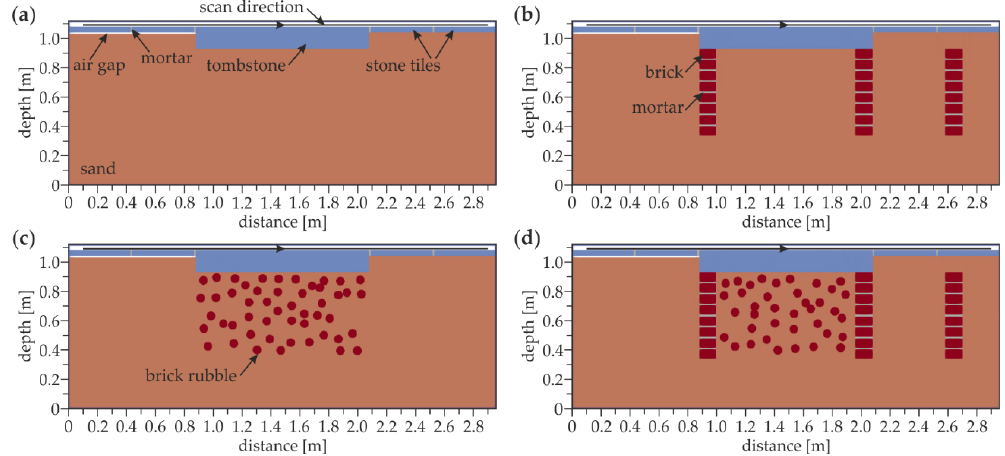
Figure 9. Finite ‐ difference time ‐ domain (FDTD) model of the floor: ( a ) model #1.1; ( b ) model #1.2; ( c ) model #1.3; ( d ) model